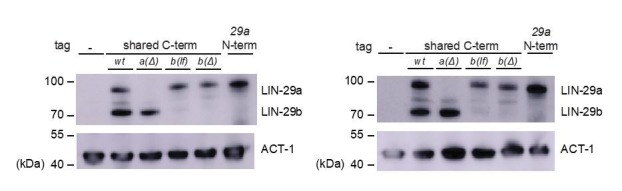
Replicate Western blot experiments.